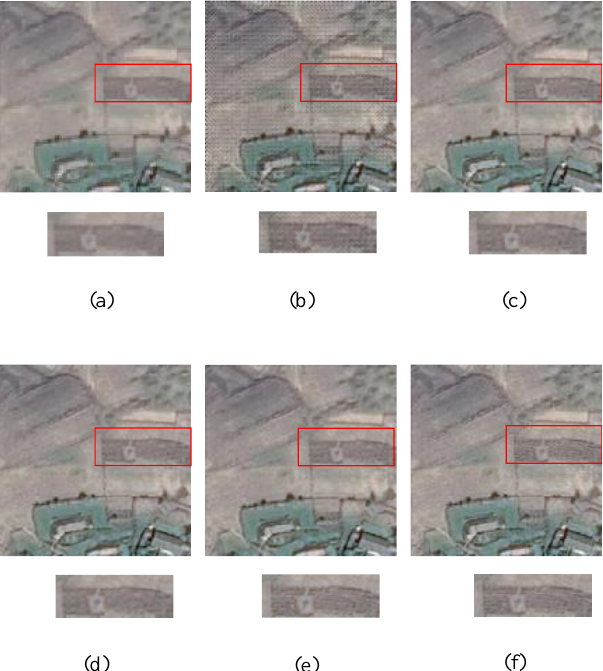
Figure 5. Comparison of reconstruction results using the Satellite dataset II(East Asia): ( a ) bicubic; ( b ) ESPCN; ( c ) SRCNN; ( d ) EDSR; ( e ) DBPN; and ( f )